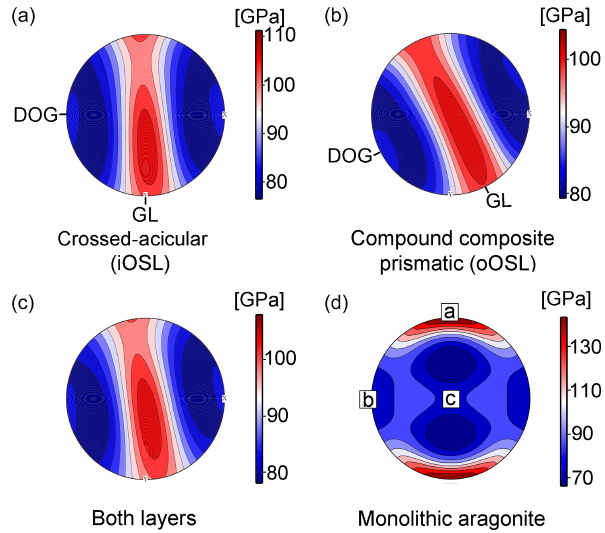
Figure 7. Young’s moduli (upper hemisphere and equal area projec- tion) for the compound composite prismatic (oOSL, a ) and crossed- acicular ultrastructure (iOSL, b ) as well as for both layers to- gether (c) . Calculations were made with the Hill averaging scheme (colour scale on the right). (d) The Young’s modulus for a arago- nite single crystal is calculated with the Voigt–Reuss–Hill averag- ing scheme and is based on the elastic constants published in De Villiers (1971). We used the aragonite single crystal elastic prop- erties of Liu et al. (2005) and the EBSD data collected from K. rhytiphora from this study as inputs (GL – local growth line, DOG – local direction of growth. Note the reference frame for (d) is given by the aragonite crystallographic